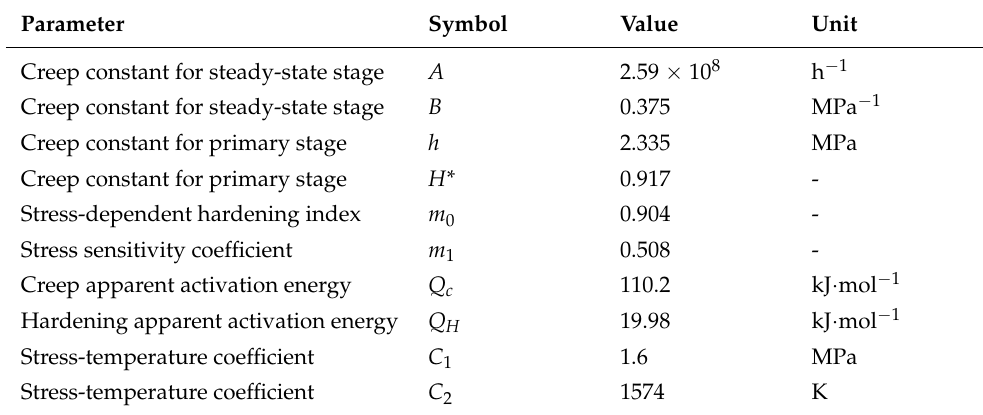
Table 2. Creep-constitutive parameters for AA2024 aluminum